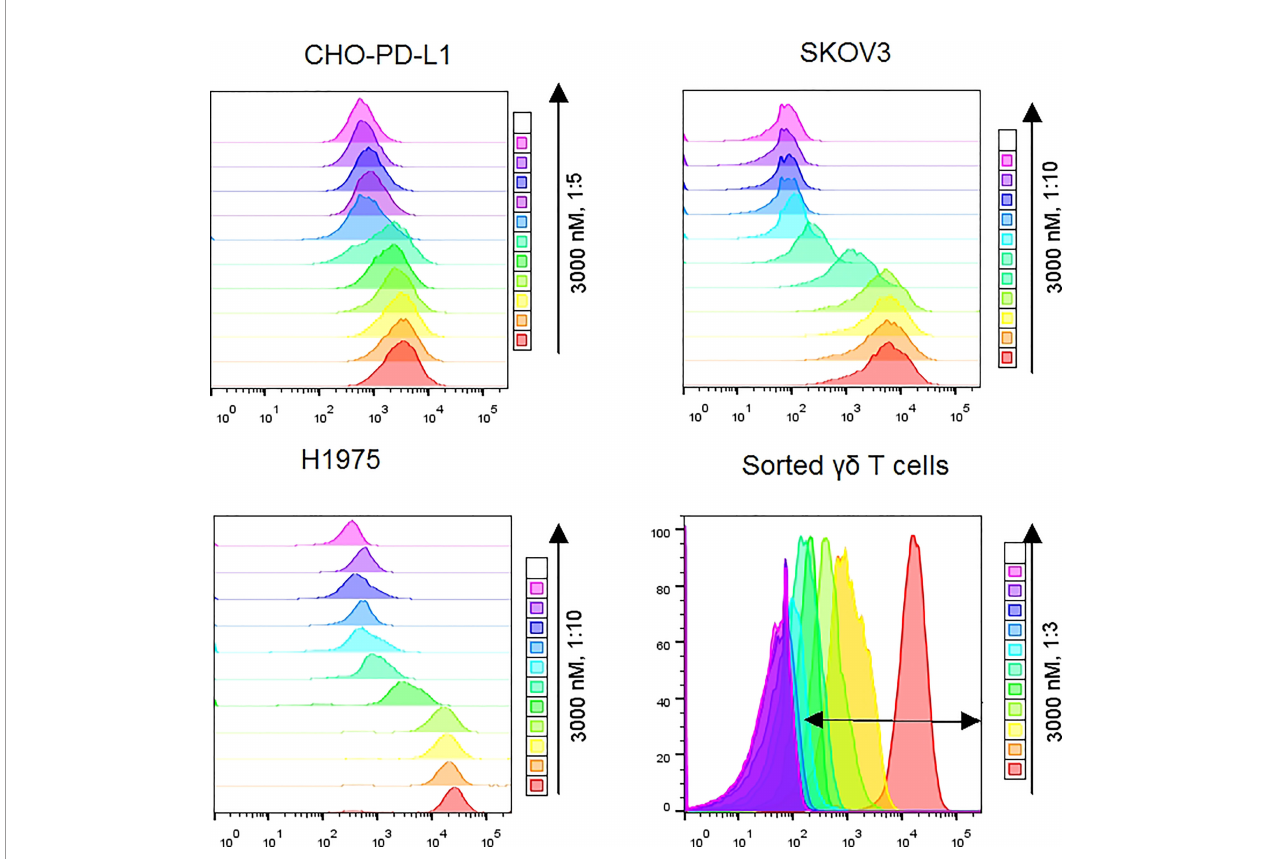
FIGURE 2 | Representative fl ow cytometry plots showed MFI differences along with doses of V g 2 x PD-L1 for CHO-PD-L1, SKOV3, and H1975 cells. For sorted gd T cells, the double-headed arrow indicated the APC positive